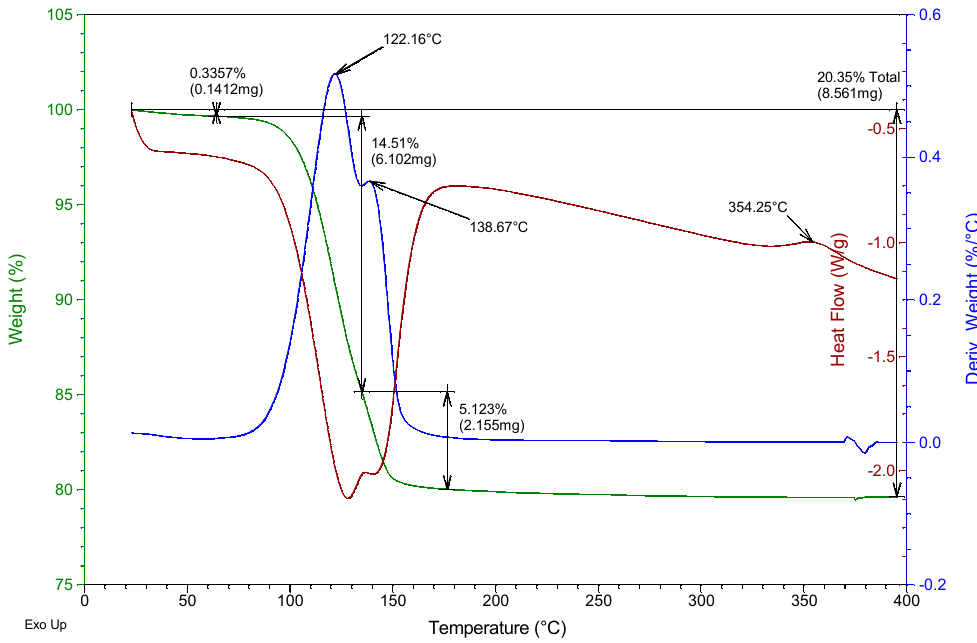
Figure 10. Thermogravimetric analysis of the E35-0.7 test tube aged 7 days. Materials 2020 , 13 , x FOR PEER REVIEW